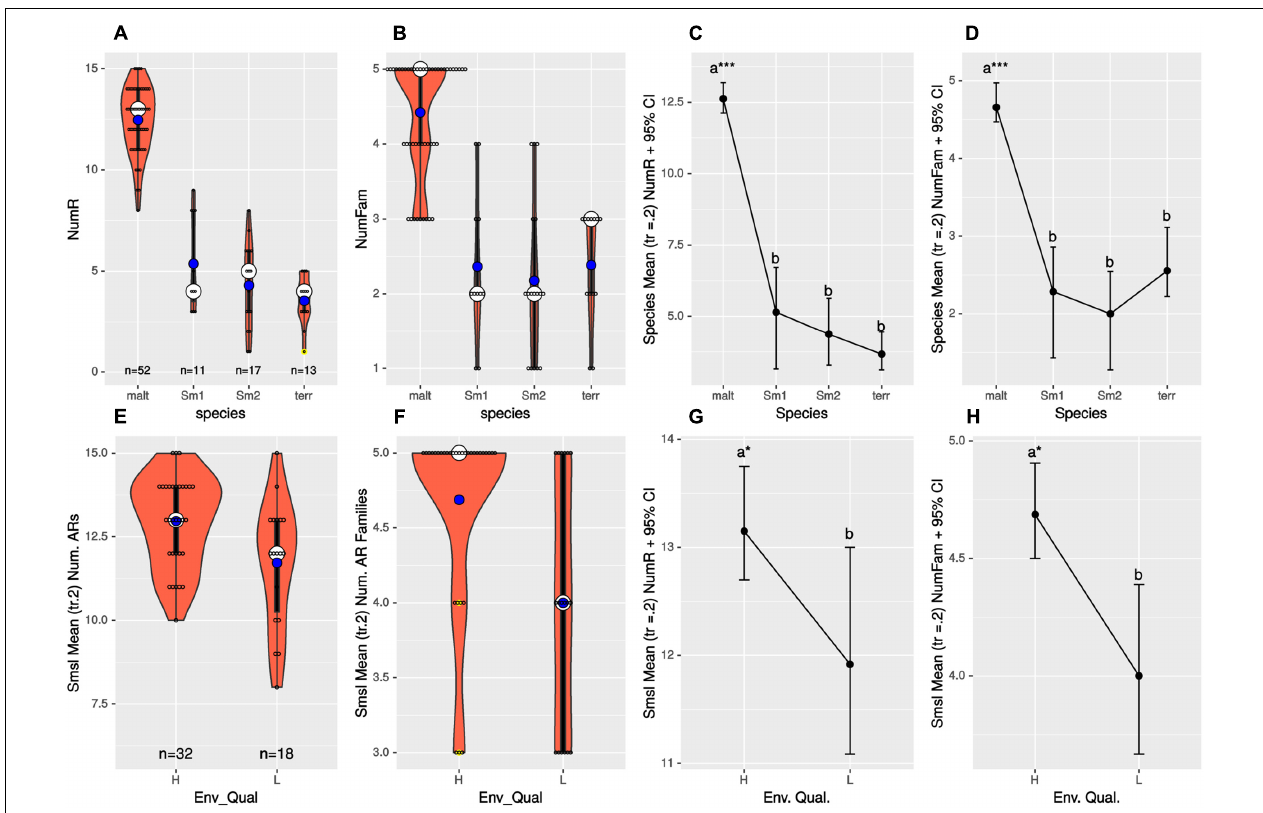
FIGURE 4 | (A,B,E,F) display violin and boxplots for the raw count data of number of resistances to individual antimicrobials (NumR) and distinct drug families (NumFam) for Mexican environmental isolates. The big white dot shows the median and the smaller blue one the mean of the distribution of individual observations, represented as small open circles. Yellow dots indicate outlier data points. (C,D,G,H) Show meanplots for NumR and NumFam (see labels on the ordinates) for 20% trimmed means and 95% confidence intervals estimated by non-parametric bootstrap ( nboot = 1000). Upper row panels (A–D) correspond to analyses for the Mexican isolates classified in the four species/lineages indicated on the x -axes. Lower panels (E–H) correspond to Mexican S. maltophilia isolates recovered from high and low pollution sites, based on the criteria indicated on Table 1 . The 4 S. maltophilia isolates recovered from sites with intermediate contamination level were excluded, as only populations of organisms with > 10 isolates were considered. Species codes are as defined in Figure 3